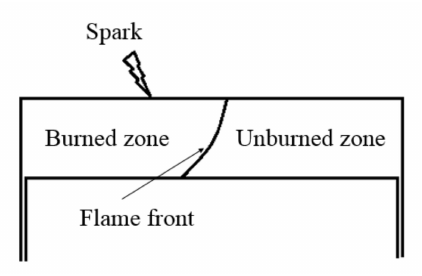
Figure 3. Two zone combustion methodology schematic diagram.